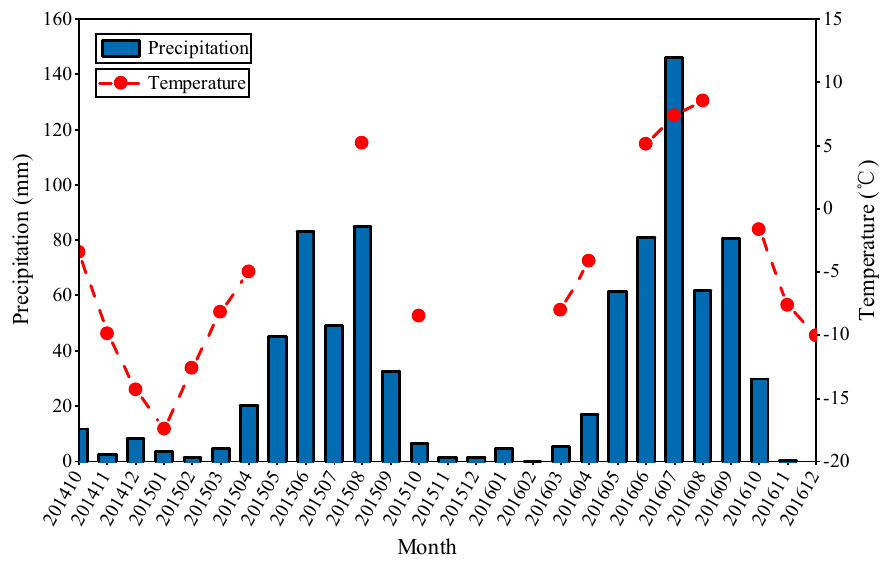
Figure 13. The monthly air temperature and precipitation data recorded during October of 2014 through December of 2016 around the DDG. The precipitation is denoted by the blue bar, while air temperature (with missing data for few months) is denoted by the red dotted curve.